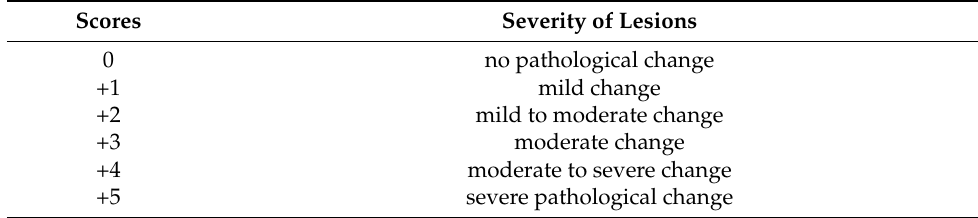
Table 2. The scoring system for each kidney sample.